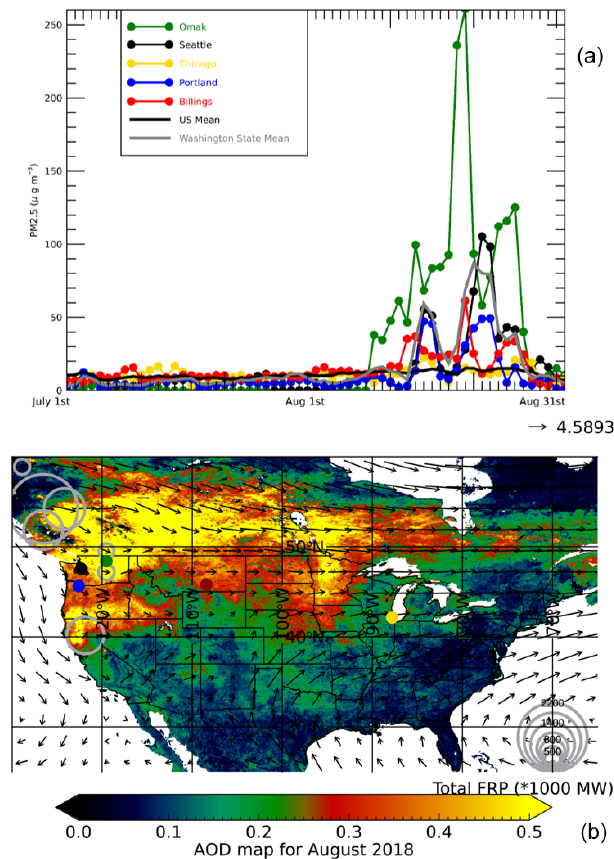
Figure 2. (a) Variations of EPA ground-observed PM 2 . 5 in differ-